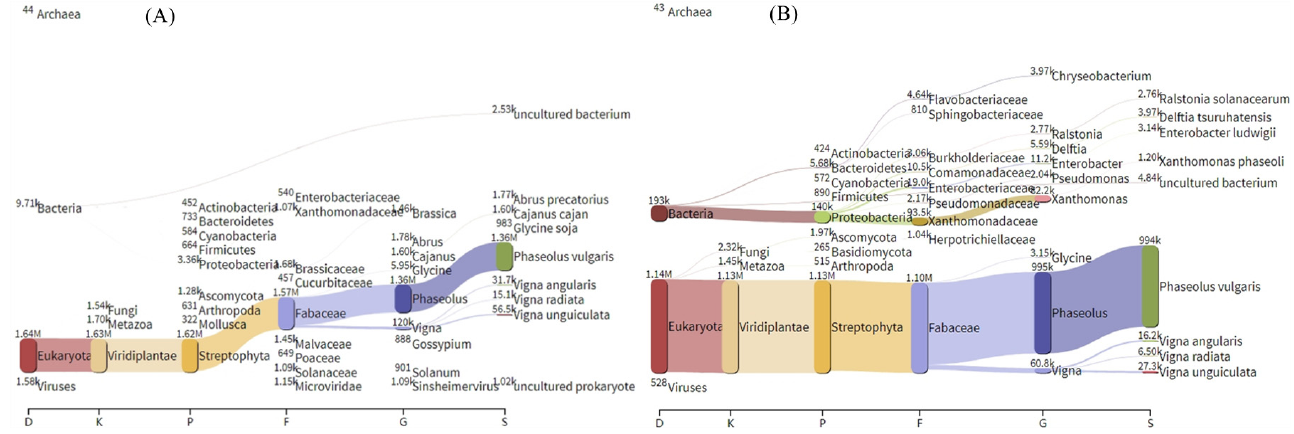
Figure 7. Sankey diagram of species composition of common soybean. ( A ) Species composition of common soybean before inoculation with X. phaseoli pv. phaseoli CFBP6546R. X. phaseoli cannot be seen in the picture. ( B ) Species composition of common soybean after inoculation with X. phaseoli pv. phaseoli CFBP6546R. X. phaseoli can be seen in the picture.